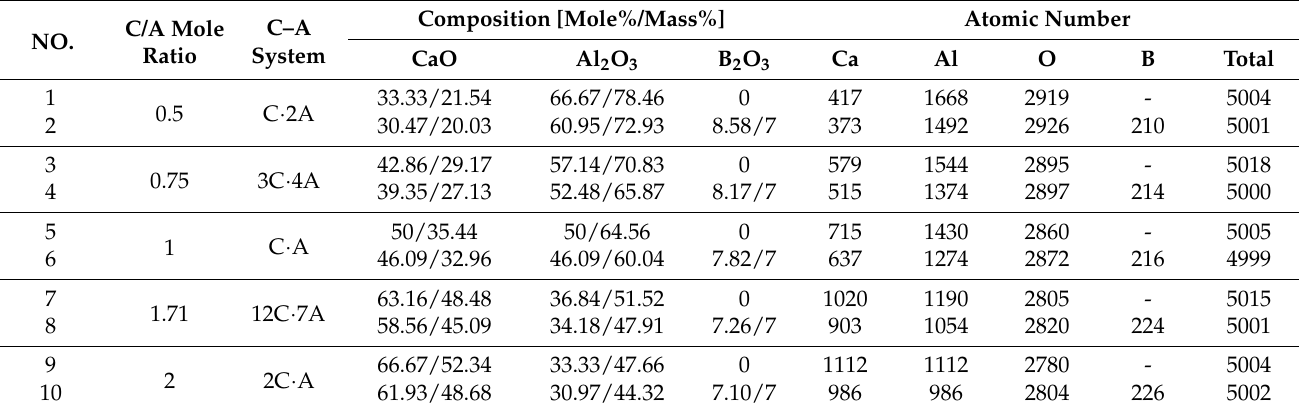
Table 2. Compositions of the studied CaO–Al 2 O 3 and CaO–Al 2 O 3 –B 2 O 3